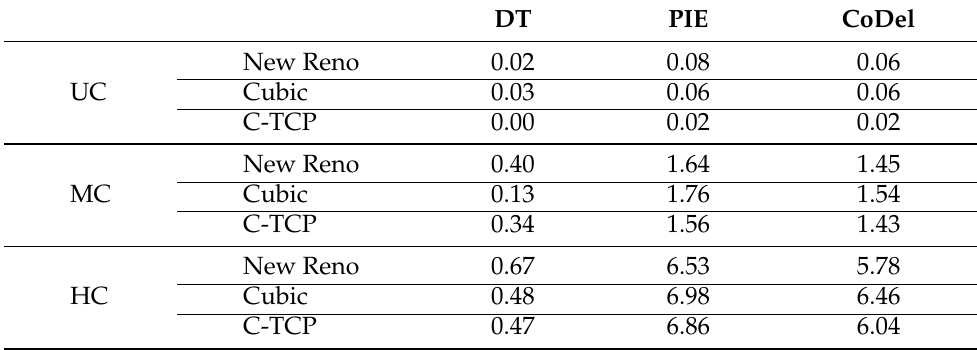
Table 5. Packet drop ratio [%] in the Data center scenario with common TCPs, UC—uncongested, MC—mildly congested, HC—heavily congested